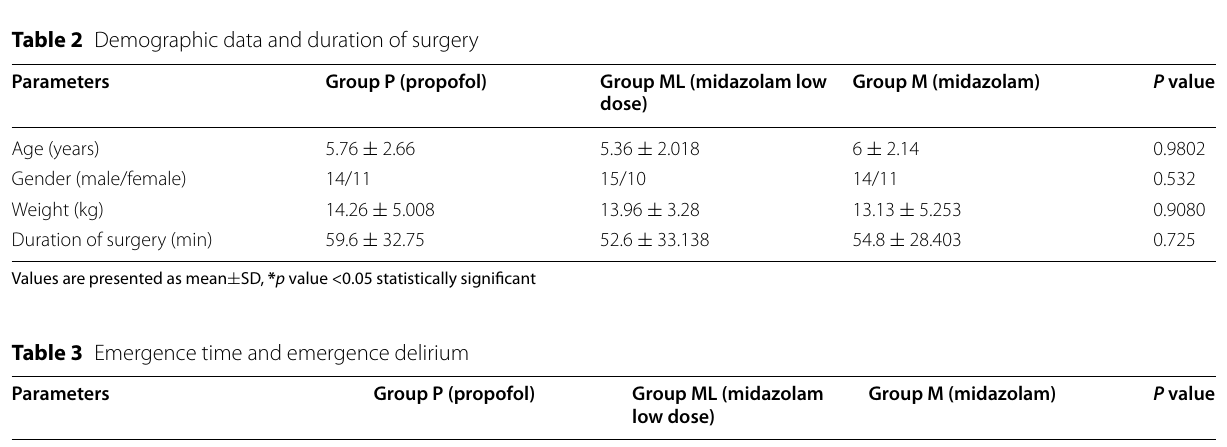
Table 2 Demographic data and duration of surgery